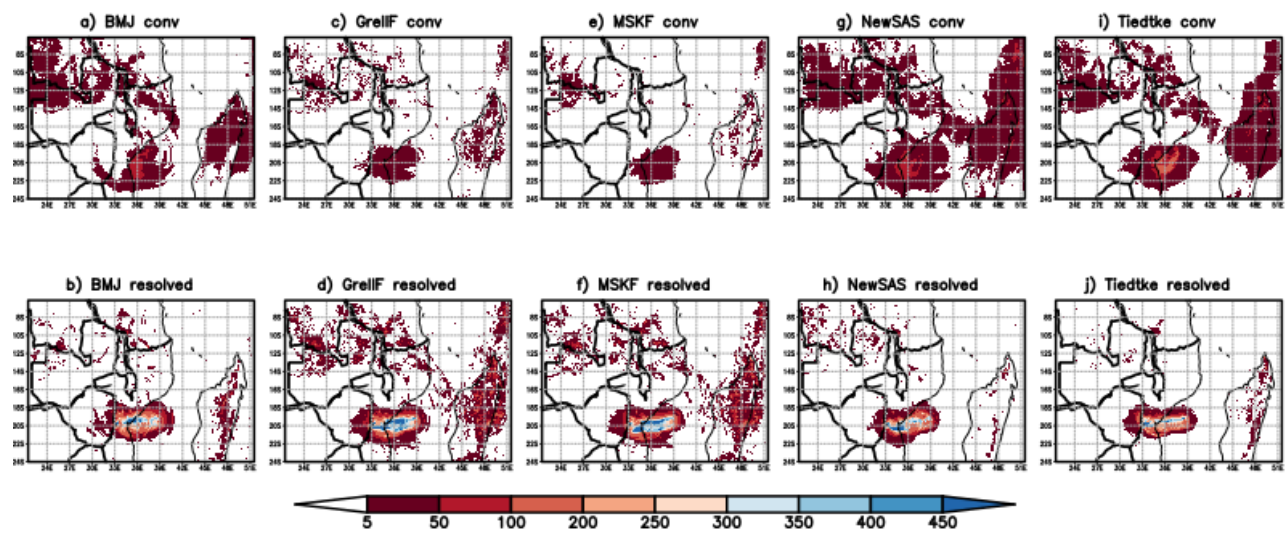
Figure 6. Accumulated rainfall (mm) for 13–15 March from simulations using ( a , b ) the BMJ scheme, ( c , d ) the Grell– Freitas scheme, ( e , f ) the MSKF scheme, ( g , h ) the NewSAS scheme and ( i , j ) the new Tiedtke scheme. The convective and resolved components of the model rainfall are presented in the left (panels ( a , c , e , g , i )) and right (panels ( b , d , f , h , j )) columns,